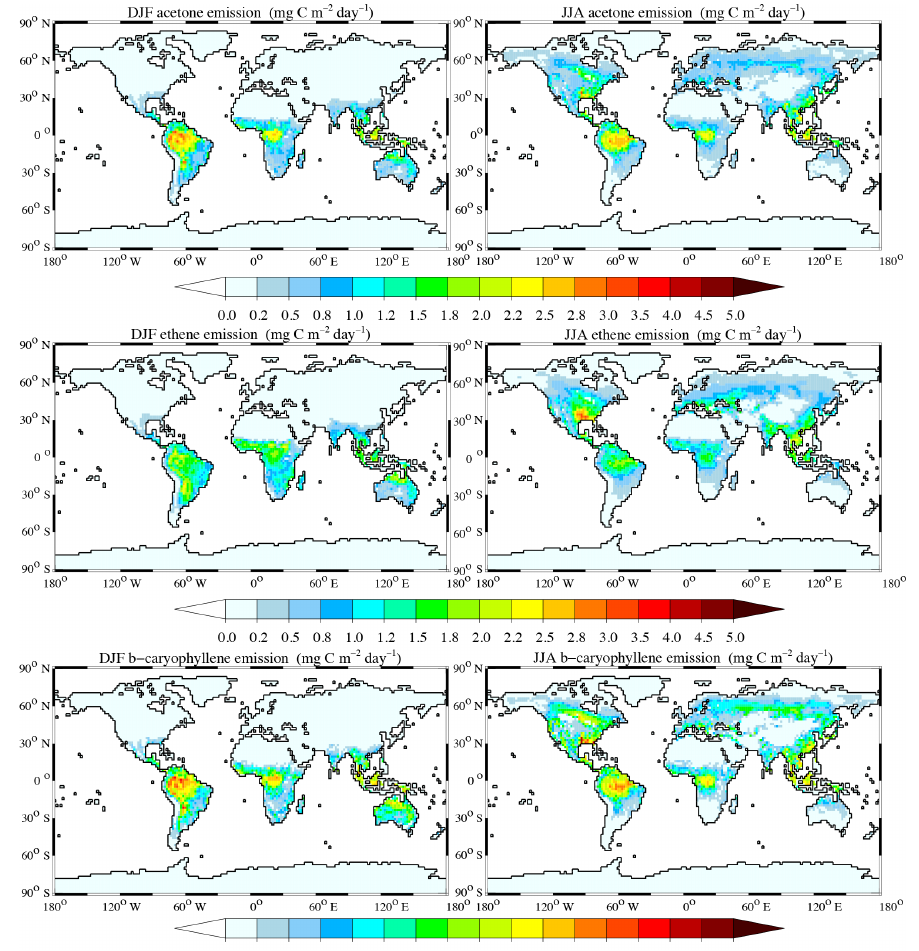
Figure 4. Same as Fig. 3 for acetone, ethene, and β